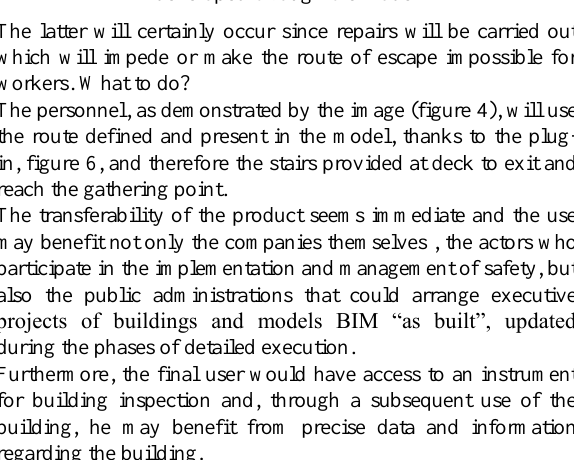
Figure 7. Analysis of the building historical evolution developed through the model